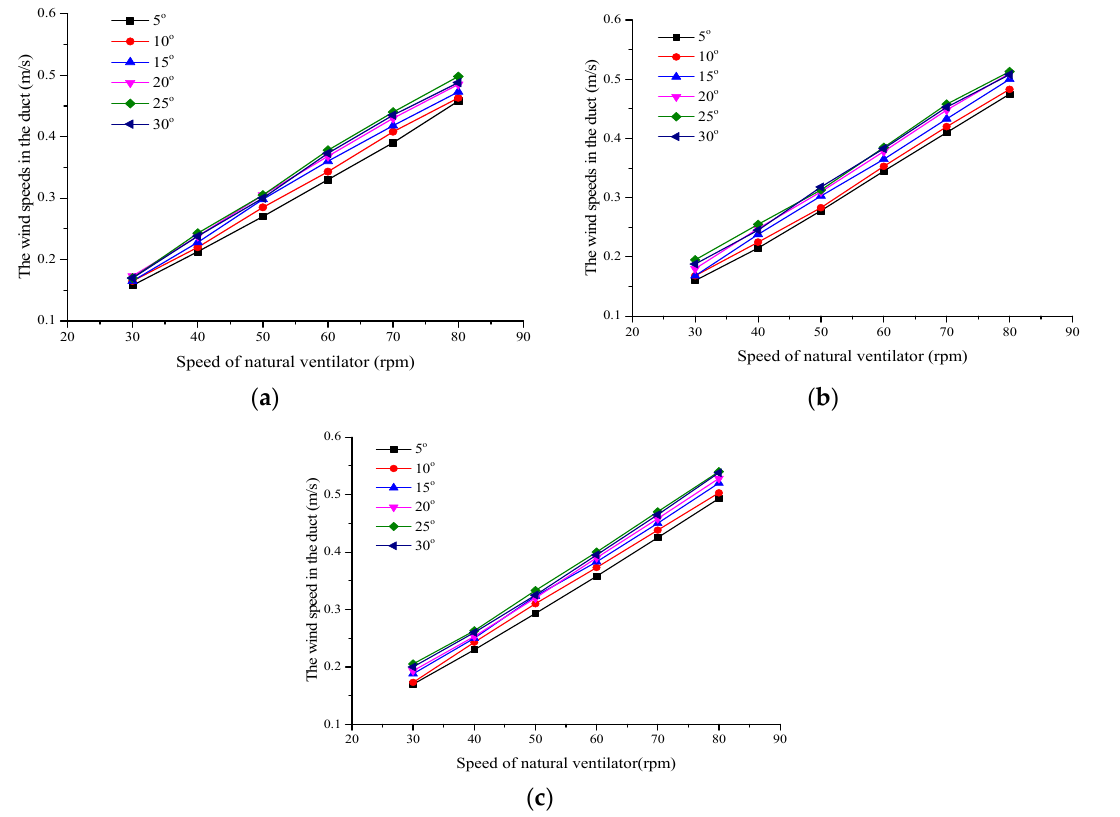
Figure 17. Relationships between wind speed in the air duct and natural ventilator speed with different blade inclination angles at different testing points. ( a ) Testing point 3; ( b ) Testing point 4; ( c ) Testing point 5.